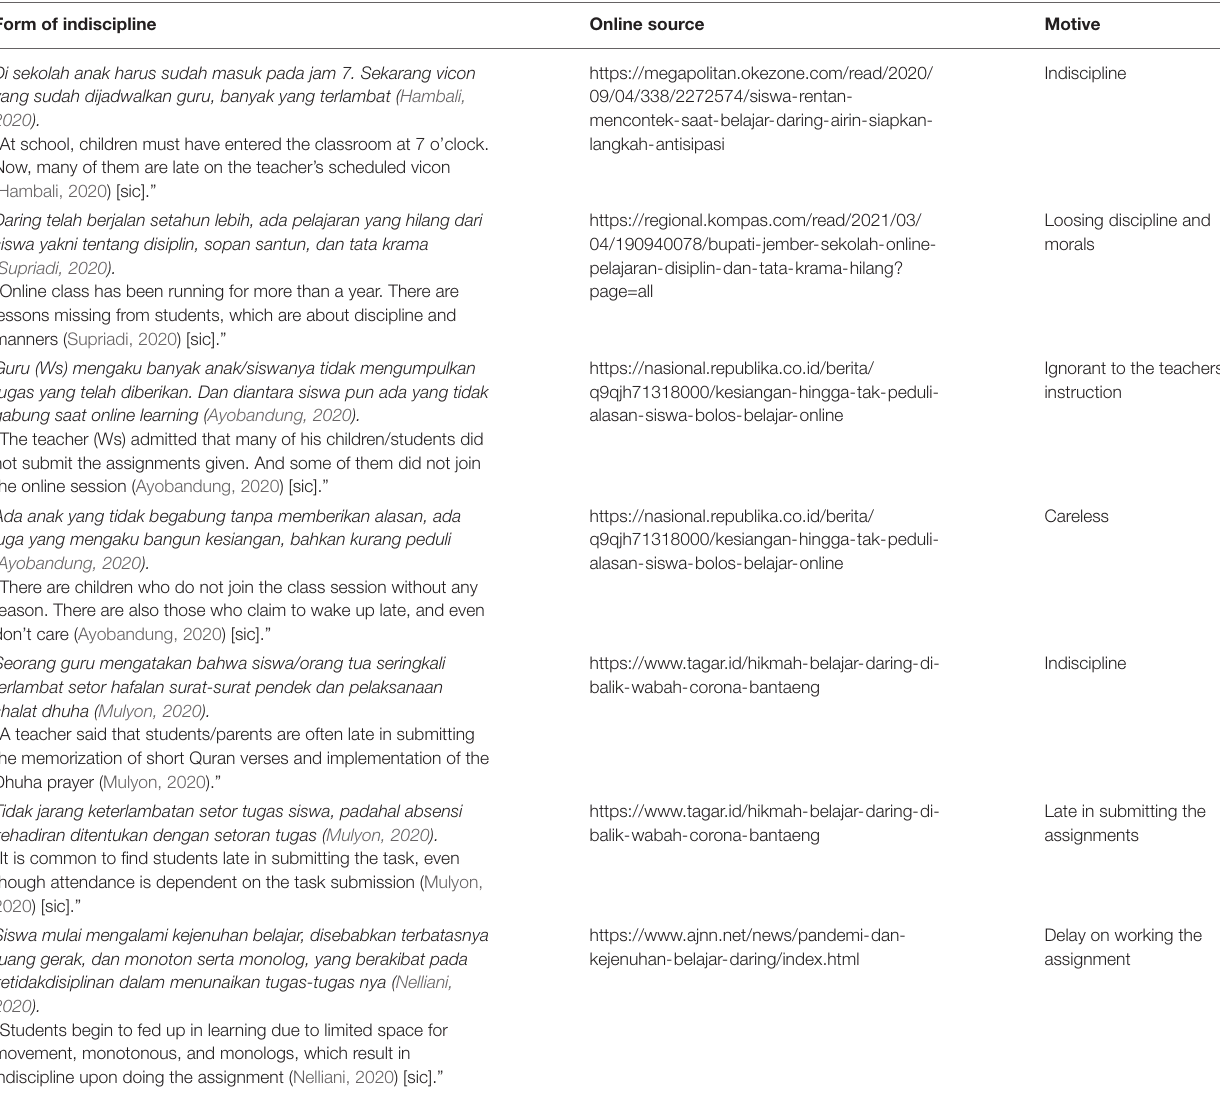
TABLE 3 | Forms of student